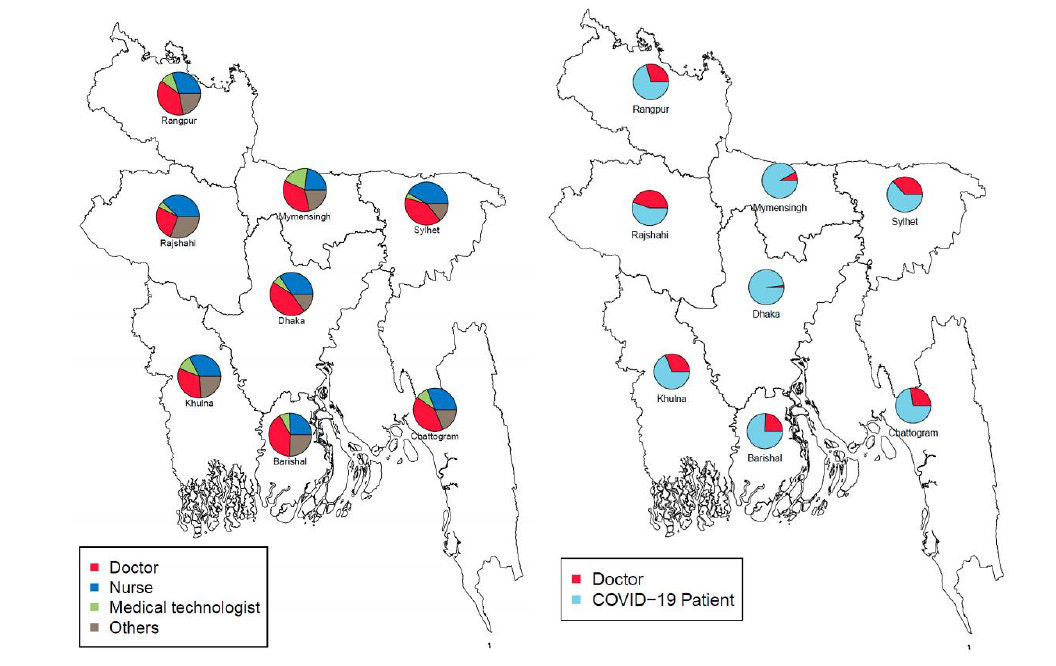
Figure 3. Division-wise conveyance of health care staff (left board) and proportion of COVID-19 patients and specialists in the divisions of Bangladesh (right board)